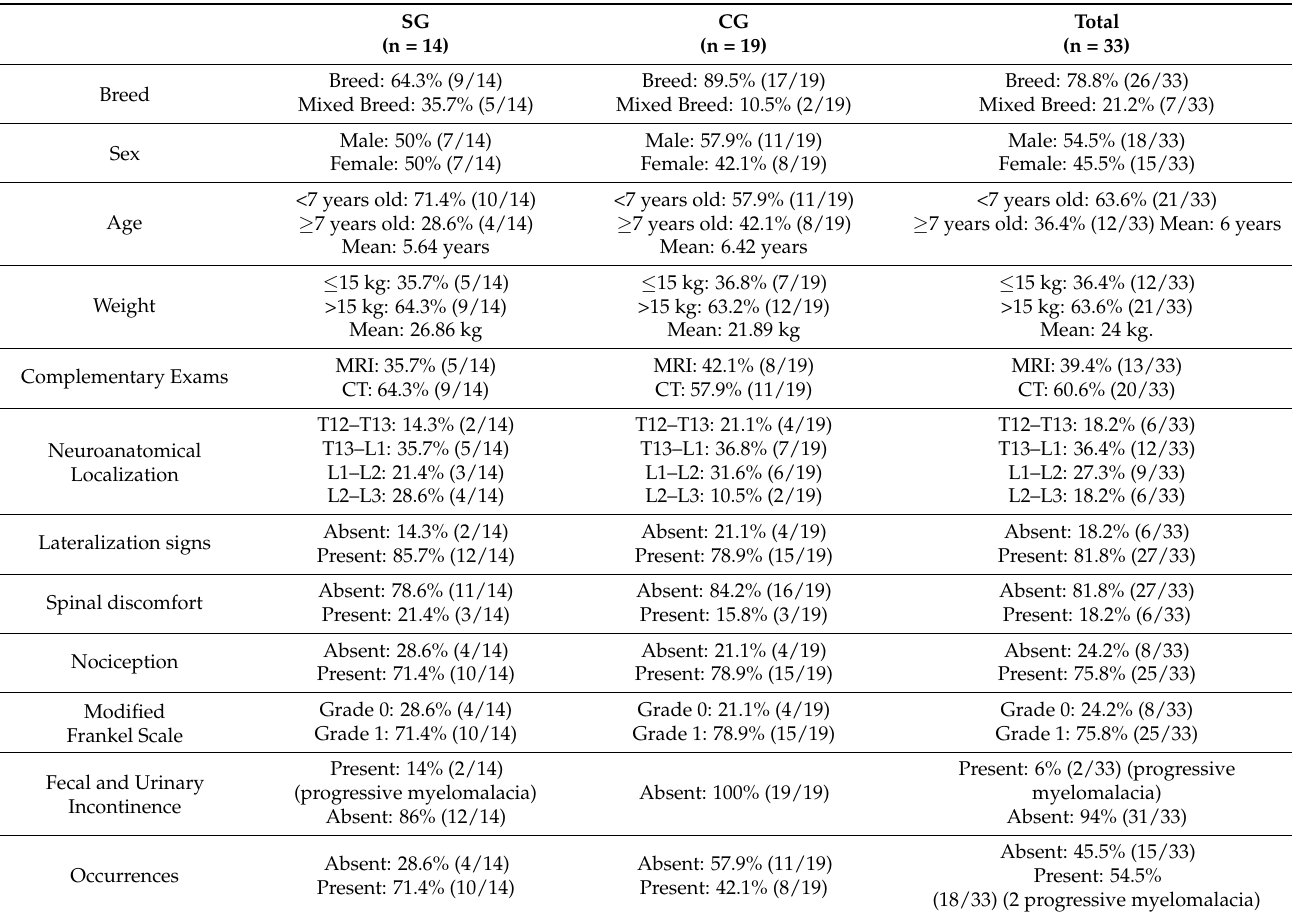
Table 1. Sample characterization of both the control and study